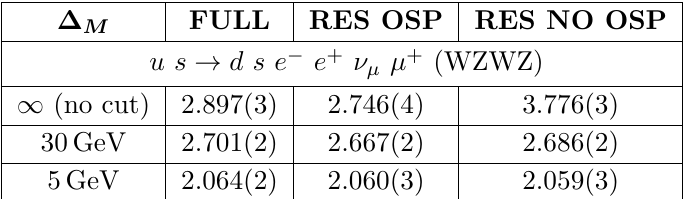
d s e (cid:0) e + (cid:23) (cid:22) (cid:22) + , for M M Z < (cid:1) M and M e + e (cid:0) (cid:0) (cid:22) + (cid:23) (cid:22) (cid:0) ! j j j > 20 GeV ; (cid:17) j < 5 : 5 ; M jj > 600 GeV ; (cid:1) (cid:17) jj > t j j j j > 40 ‘ + ‘ (cid:0)